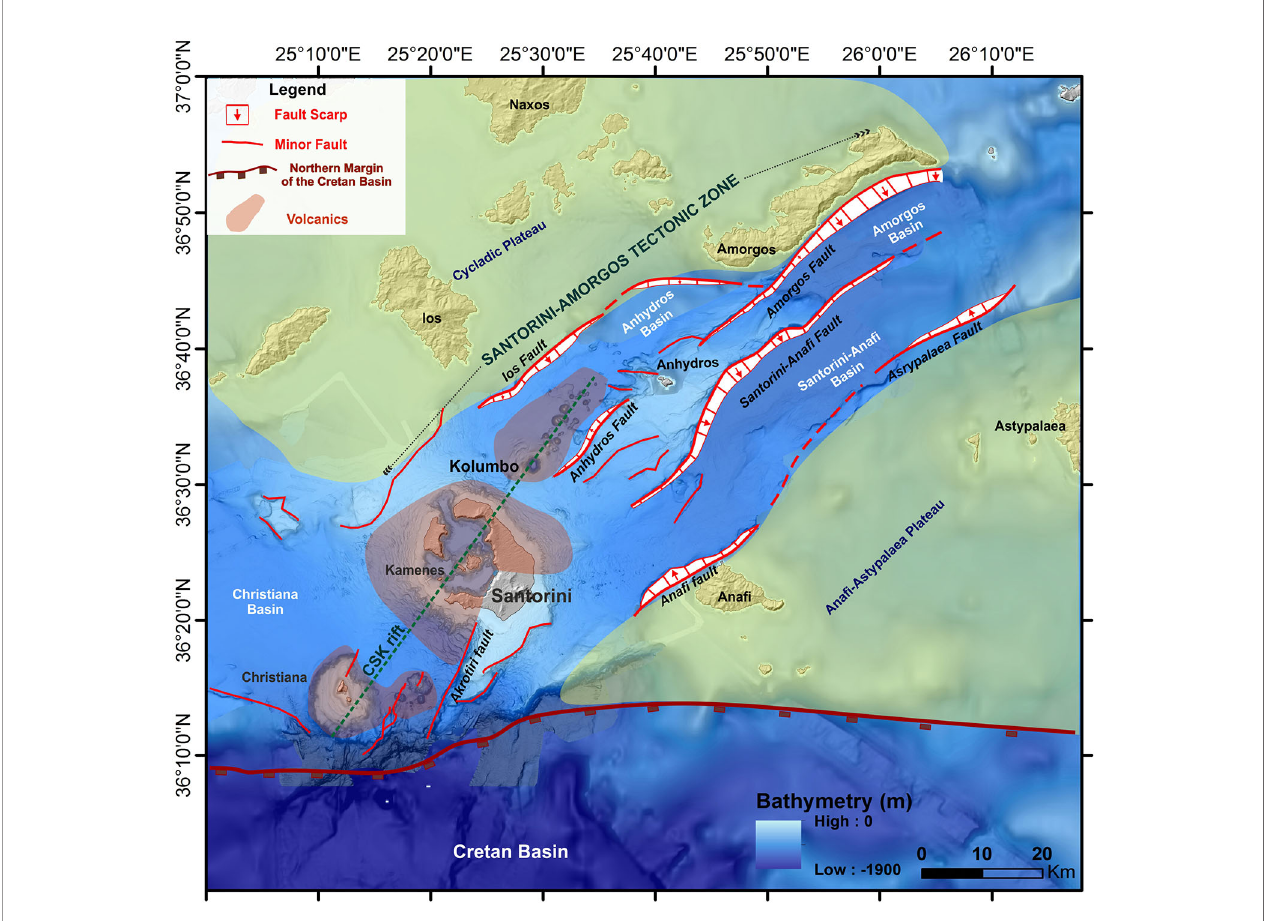
FIGURE 1 | Christiana-Santorini-Kolumbo rift (South Aegean Sea, Greece) (Nomikou et al., 2018; Nomikou et al.,